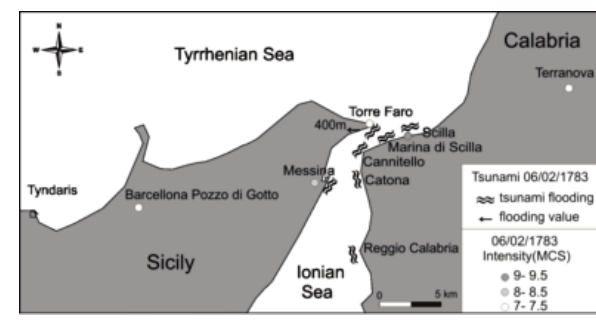
Figure 10. Index map of archaeoseismic evidence for the 4th century AD event in southern Calabria and northeastern Sicily. In brackets the current place names modified from Galli and Bosi [2002]. The triangle shows Torre degli Inglesi.